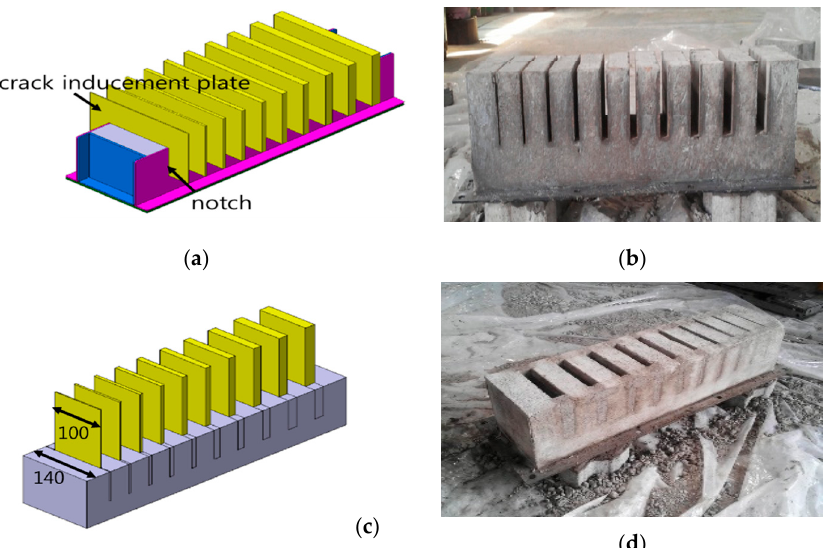
Figure 4. Crack specimen production method and crack specimen photo: ( a ) Crack generation technique using crack inducement plate; ( b ) Crack specimen generated by crack inducement plate; ( c ) Technique for side wall generation by removing the crack inducement plate after mortar cement placement; ( d ) Crack specimen in which the side wall is generated.